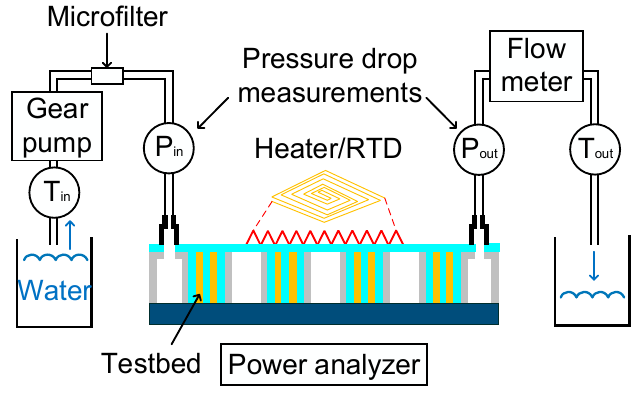
Figure 8. The silicon interposer embedded with microfluidic channels. Adapted with permission from [67], Copyright Taylor & Francis, 2016.